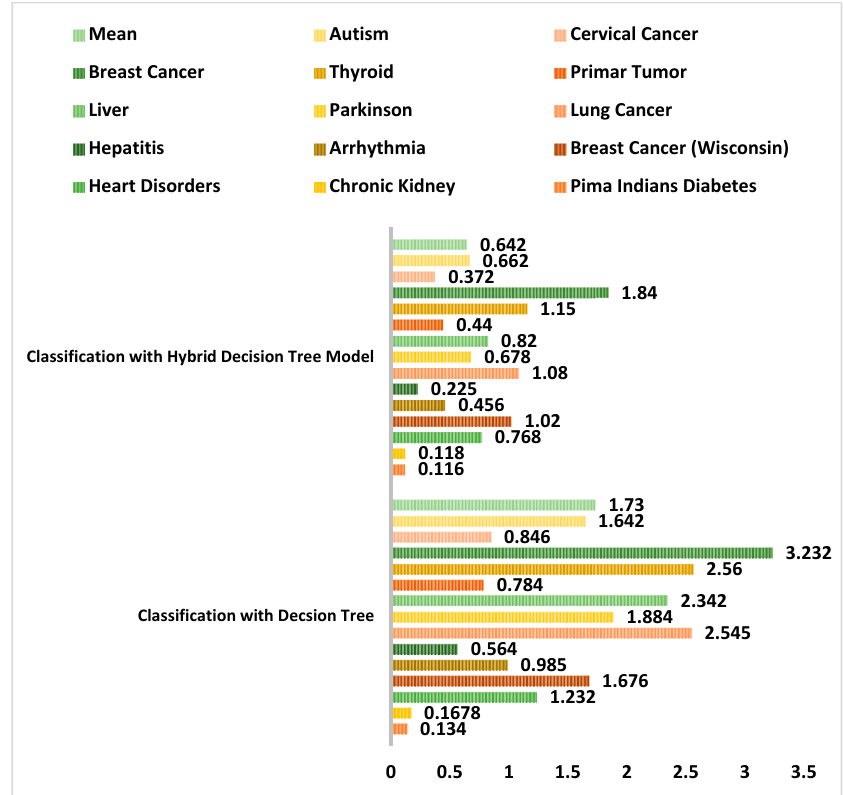
Figure 22. Comparison of error rate between the Proposed Hybrid Decision Tree and the classical decision tree method on chronic disease datasets.